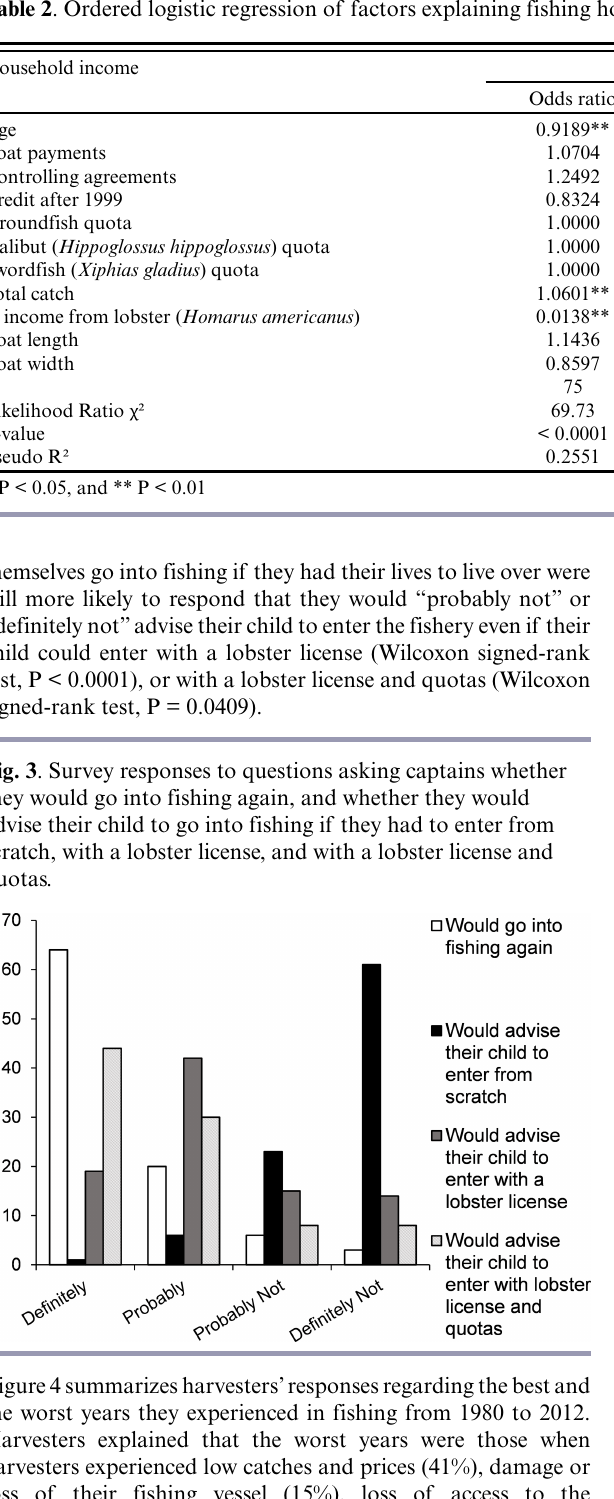
Table 2 . Ordered logistic regression of factors explaining fishing household income.